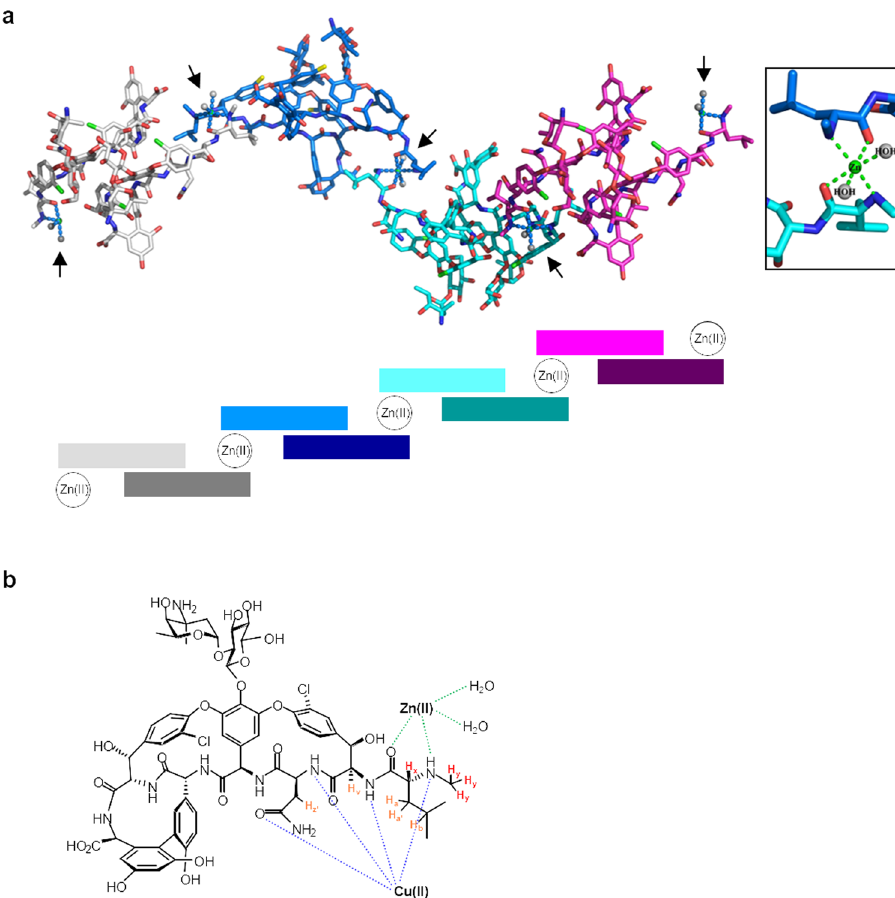
Figure 4. Zn(II) interacts with the N-terminal methylleucine of vancomycin to produce a novel polymer of dimers. ( a ) Crystal structure of vancomycin-Zn(II) determined by X-ray crystallography. Zn(II) ions (indicated by arrows) hold dimers of vancomycin in a polymeric structure, as also illustrated in the schematic representation showing the arrangement of vancomycin molecules (coloured rectangles, stacked in dimers) and Zn(II) ions in the polymer. The inset shows Zn(II) joining adjacent vancomycin dimers via ionic interaction with the carbonyl (in red) and secondary amine (in blue) groups of the N-terminal methylleucine group. ( b ) Chemical structure of vancomycin indicating the site of interaction with Zn(II) relative to